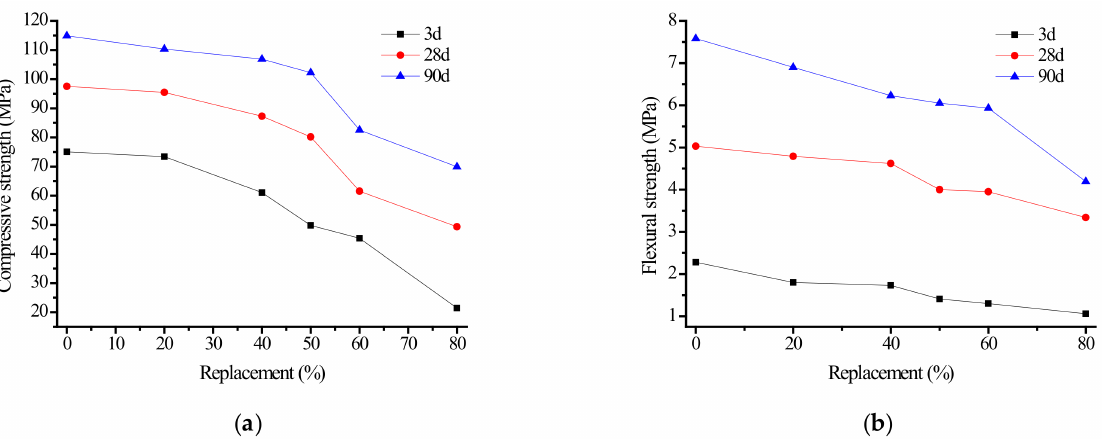
Figure 2. Effect of fly ash content on strength of alkali slag cement paste. ( a ) Compressive strength, ( b ) Flexural